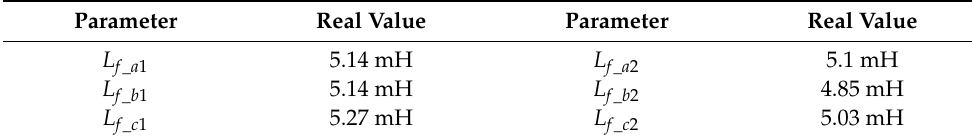
Table 6. Real values of the inductance L f of 5 mH.